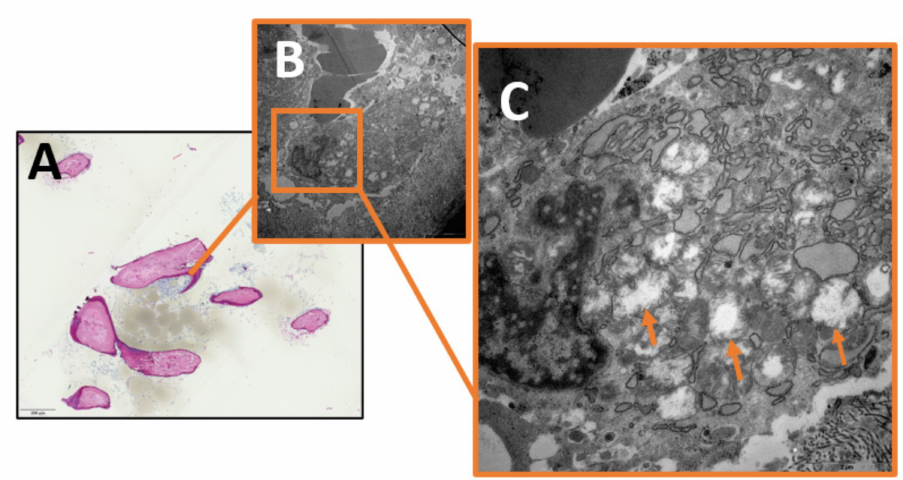
Figure 3. ( A ) Light microscopy image of infectious bone (magnification × 40). ( B ) Magnification of ( A ). Transmission electron microscopy image of osteoblast from patient with osteomyelitis (Magni- fication × 5000). ( C ) Magnification of ( B ). Transmission electron microscopy image of perinuclear region of osteoblast. Visible cluster of swollen mitochondria with depleted cristae and reduced matrix density. Mitochondria exemplarily indicated by arrows (magnification × 20,000).